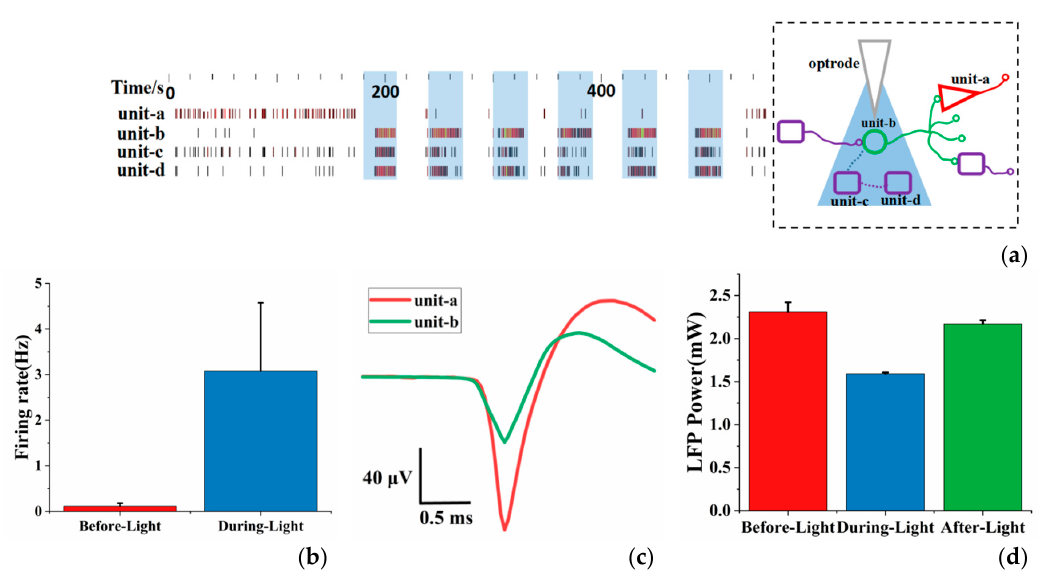
Figure 4. ( a ) The real-time recordings of spikes of 4 units separated from three recording channels (the shaded area is the period of during-light, 30sm) and inferred local circuit (the green circle represents the interneuron, the red triangle represents pyramidal neuron, the purple rectangles represent unknown type of neurons and dotted lines between neurons indicate uncertain connections); ( b ) the average spike firing rate of neurons before and during optical stimulation; ( c ) spike waveform of unit-a and unit-b; ( d ) the mean LFP power (0–8Hz) of neurons before, during and after optical stimulation. Error bars indicate standard deviation of 3 channels and N = 6 (N is the number of experiments).